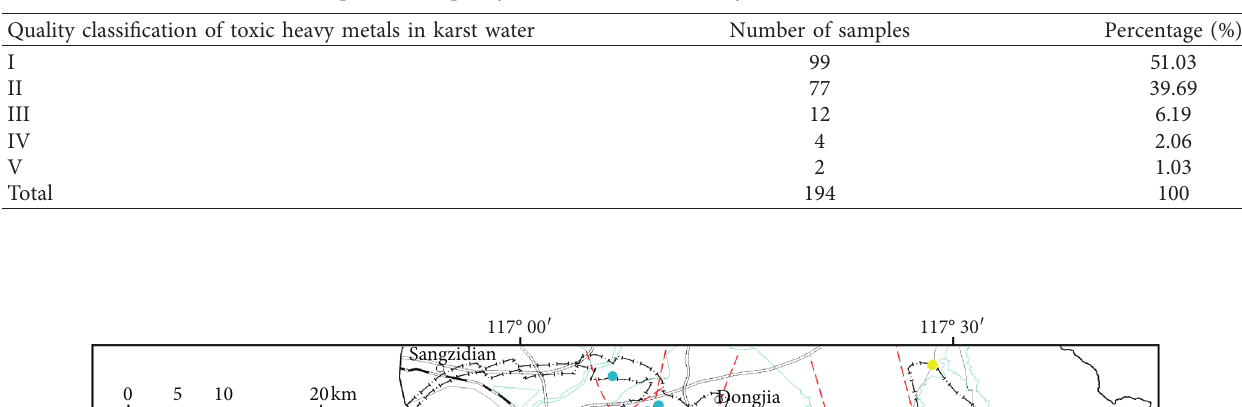
Table 4: Comprehensive quality evaluation of toxic heavy metals in fractured karst water.